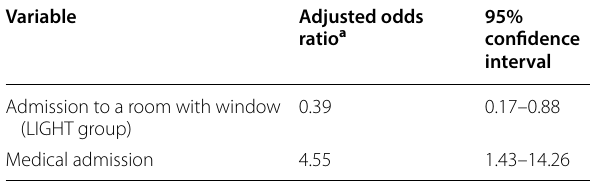
Table 4 Factors associated with the use of antipsychotics to treat agitation, multivariate analysis